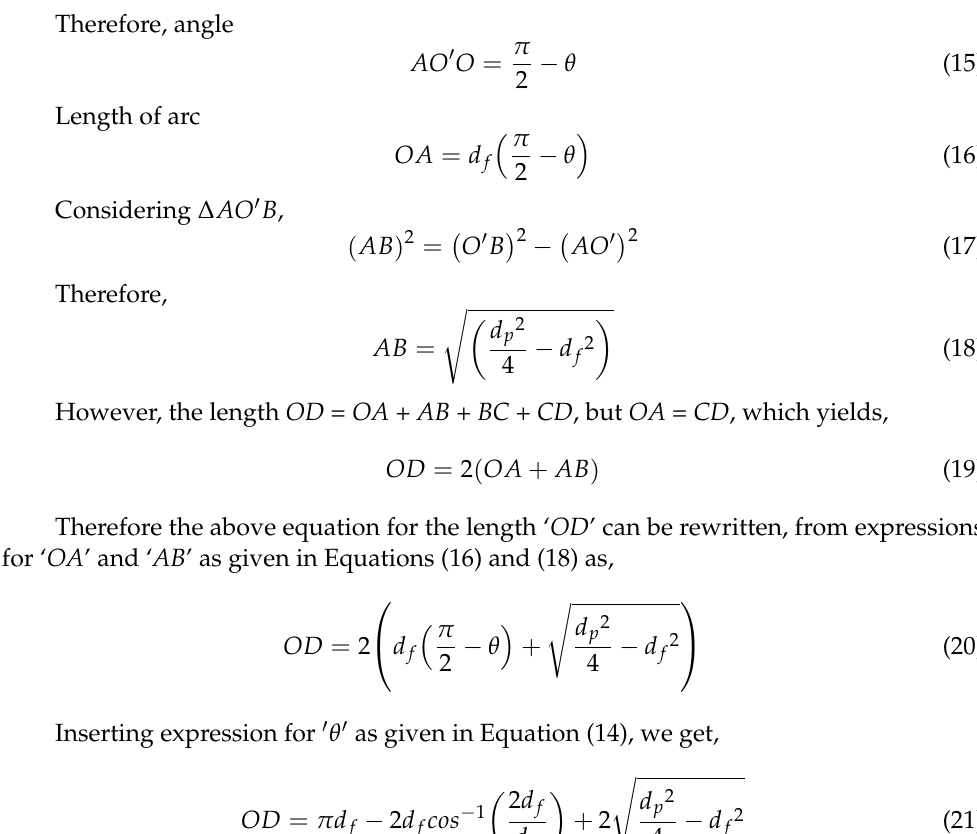
Figure 6. ( a ) Sketch of single cylindrical wire woven over straight cylindrical wires. ( b ) Description of parameters involving in expressing lengths of each woven cylindrical